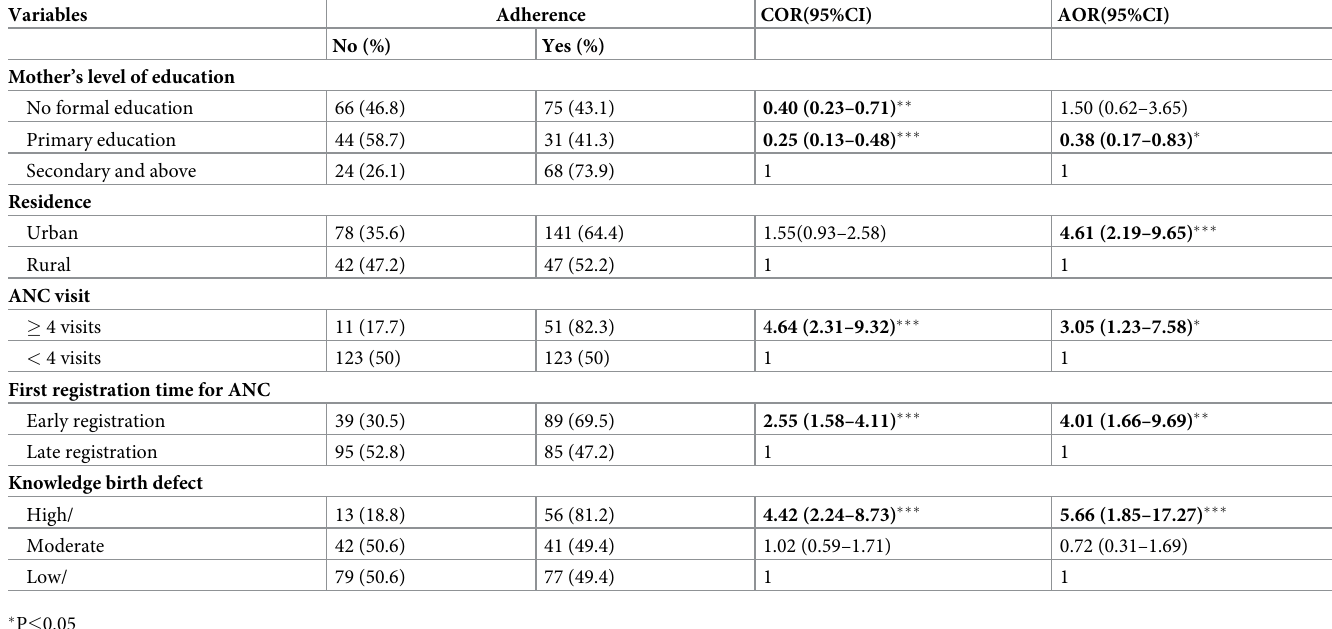
Table 4. Factors associated with adherence to iron and folate supplementation among pregnant women attending antenatal care in public health facilities at Dire Dawa, Eastern Ethiopia. n = 308.